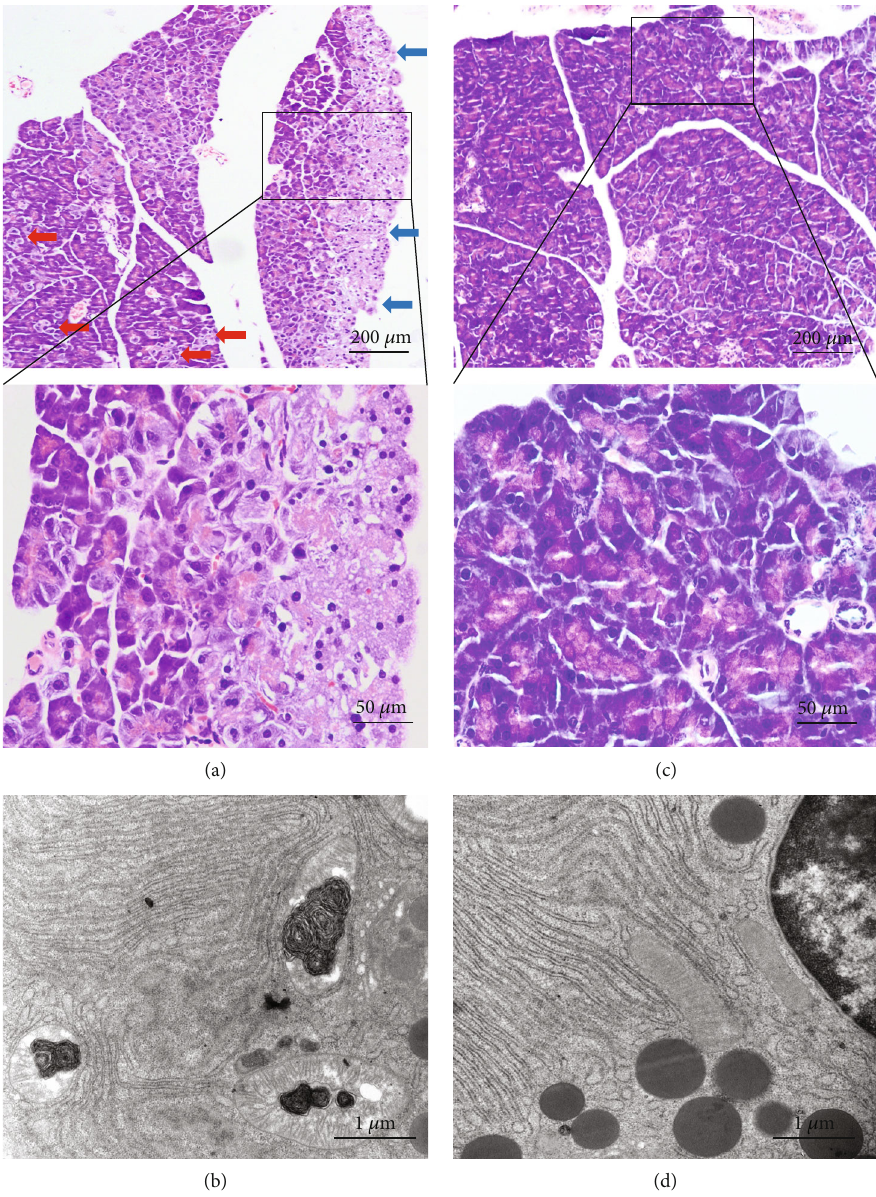
Figure 2: Representative images of pancreatic tissue sections after hematoxylin and eosin staining. (a, c) Tissue sections were examined under a phase-contrast microscopy after hematoxylin and eosin (H&E) staining. (b, d) Tissue sections were examined under a transmission electron microscope. The red arrows indicate focal necrosis, and the blue arrows indicate large patchy